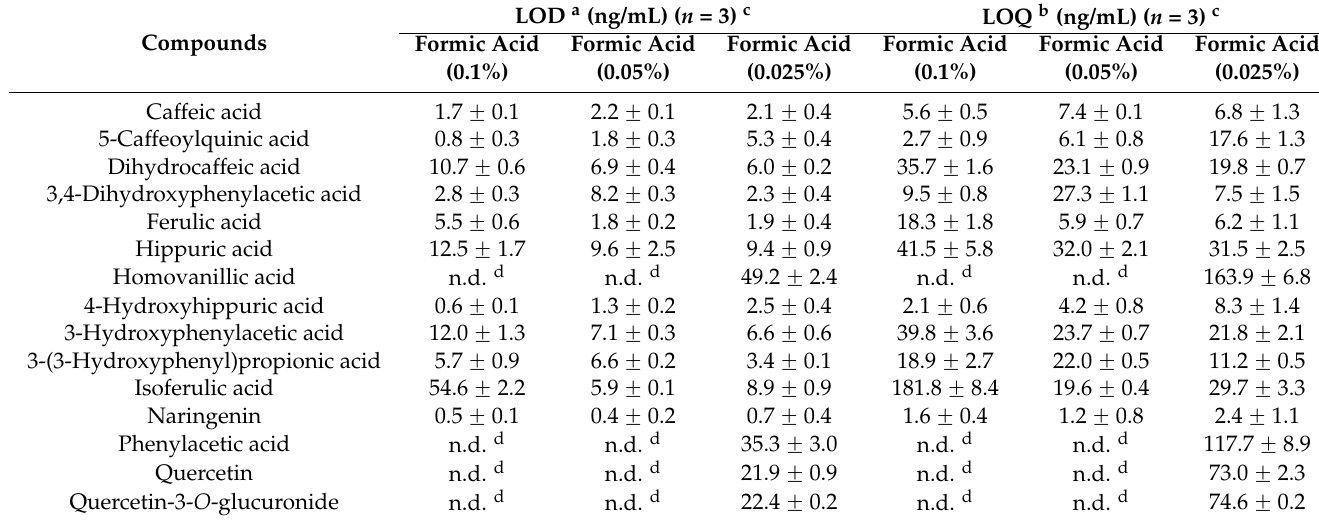
Table 1. LOD and LOQ of an aqueous mix of 15 phenolic compounds (100 ng/mL) in the study of different mobile phases by UHPLC-MS/MS.